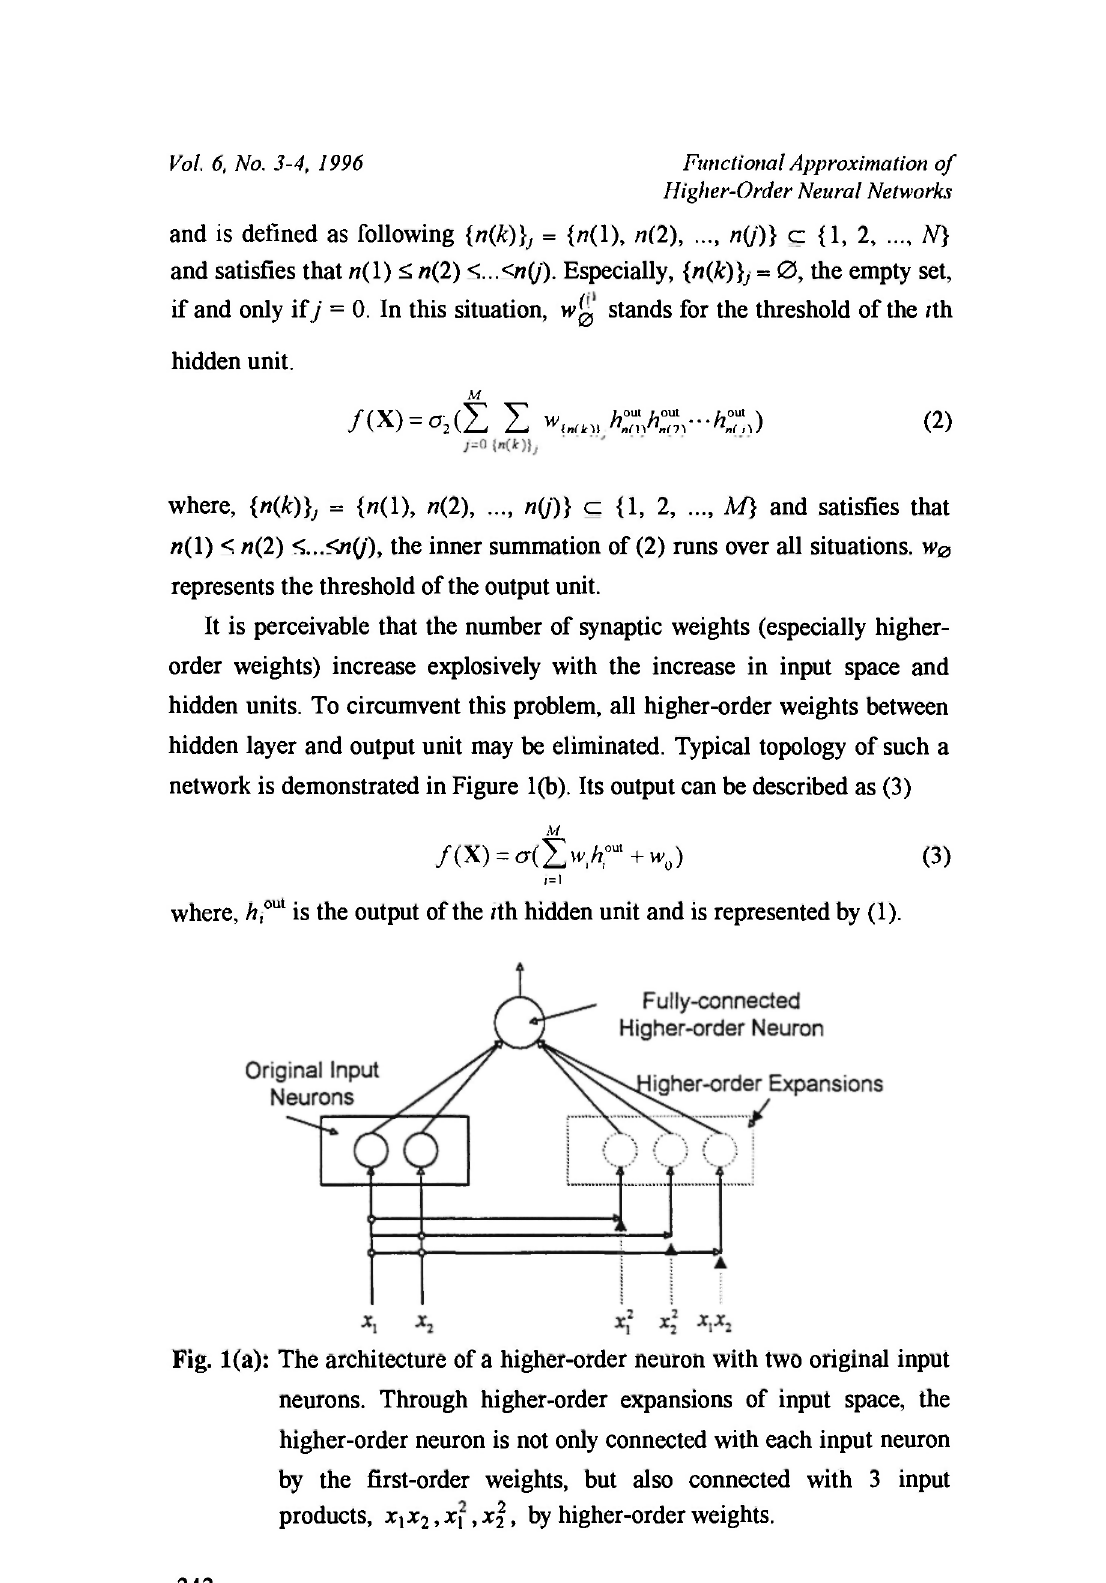
Fig. 1(a): The architecture of a higher-order neuron with two original input neurons. Through higher-order expansions of input space, the higher-order neuron is not only connected with each input neuron by the first-order weights, but also connected with 3 input products, x x ,x\,xi, by higher-order x 2